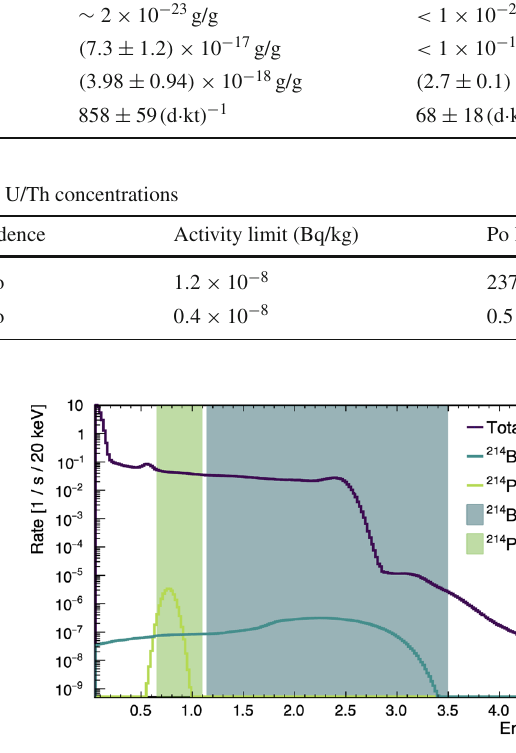
Fig. 16 Bi–Po coincidences are found based on a sequence of selec- tion cuts. Here, we display the energy selection cuts for prompt and delayed events as well as the underlying signal and background spectra for 214